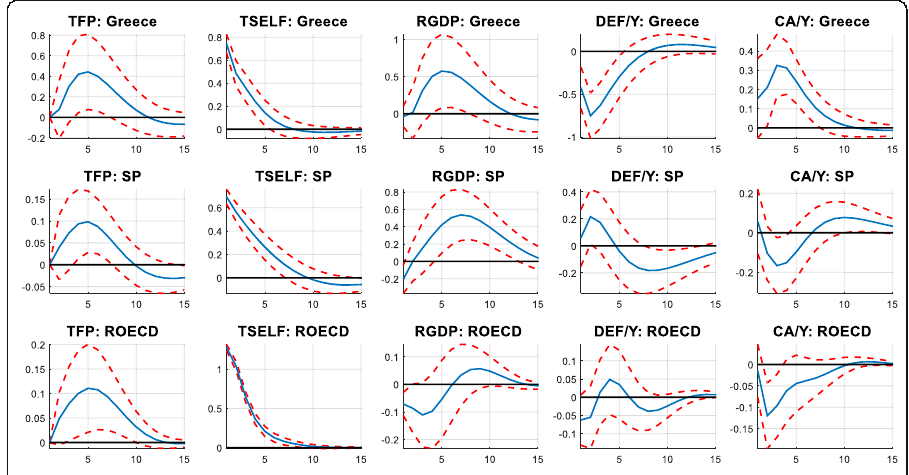
Fig. 17 Dynamic responses to a shock in TSELF